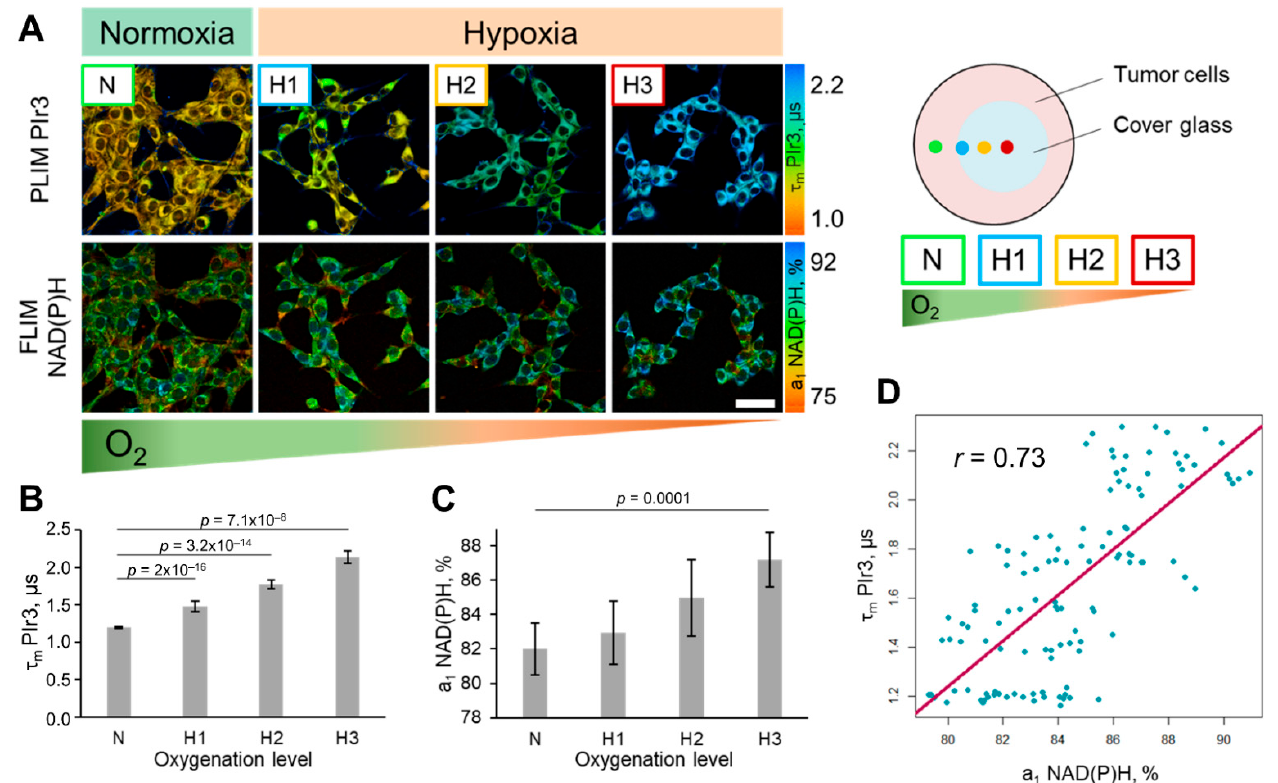
Figure 8. Simultaneous probing of oxygen and metabolism of CT26 cells in normoxic and hypoxic conditions. ( A ) PLIM images of cells with PIr3 and FLIM images of NAD(P)H from the same cells upon hypoxia induction. Scheme of the experiment on modeling hypoxia using cover glass. Scale bar = 50 µm. For FLIM: ex. 750 nm, reg. 450–490 nm. For PLIM: ex. 750 nm, reg. 570–640 nm. ( B ) Dependence of the phosphorescence lifetime of PIr3 in cells on the level of oxygenation. ( C ) Relative contribution of free NAD(P)H (a 1 , %) at different levels of oxygenation. Mean ± SD, n = 30 cells. p -values are indicated on the diagram. ( D ) Correlation between τ PIr3 and a 1 NAD(P)H. The Pearson coefficient r is shown on the scatter plot. Blue dots are the measurements from individual cells.